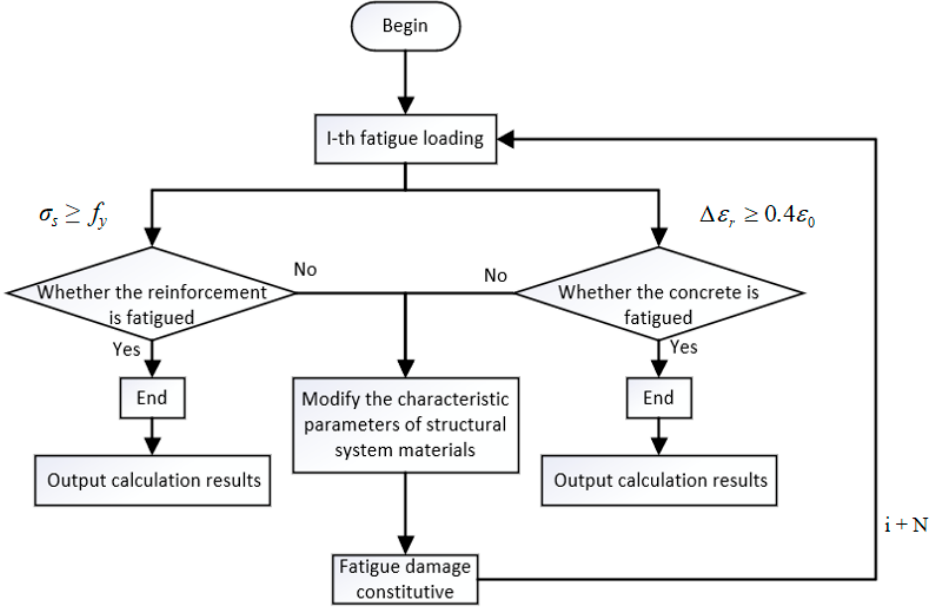
Figure 9. Whole process analysis diagram of fatigue damage of CRTSIII BT structure system.